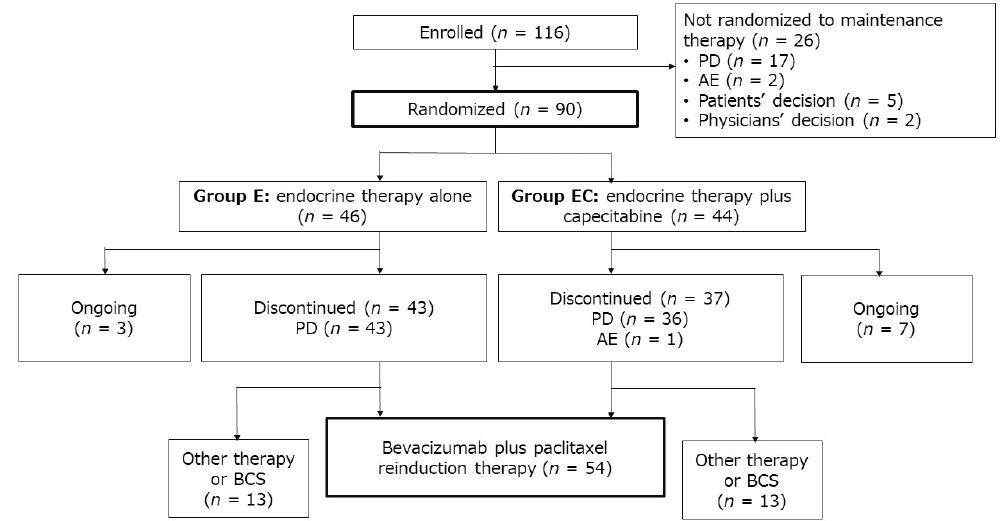
Figure 1. Patient disposition. AE, adverse event; BCS, breast-conserving surgery; E, endocrine therapy alone; EC, endocrine therapy plus capecitabine; PD, progressive disease.